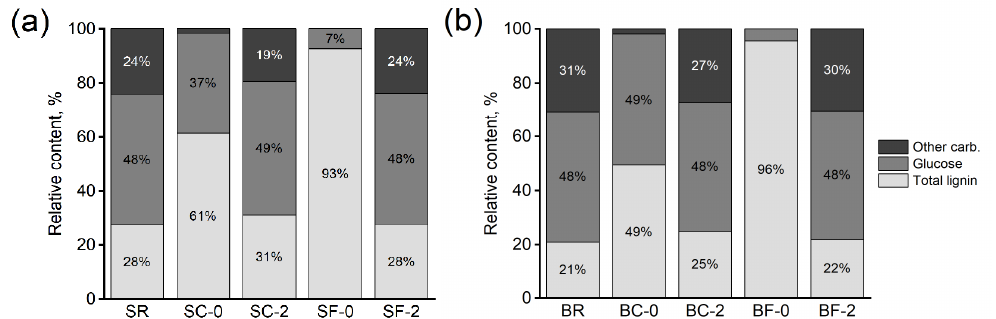
Figure 2. Relative content of total lignin (acid soluble + Klason), glucose and other carbohydrates in undecayed ( a ) spruce (SR) and ( b ) birch (BR) references and modified samples measured at 0 or 2 mm depth from the surface. R = unmodified; C = contact charred; F = flame charred; S = spruce; B =